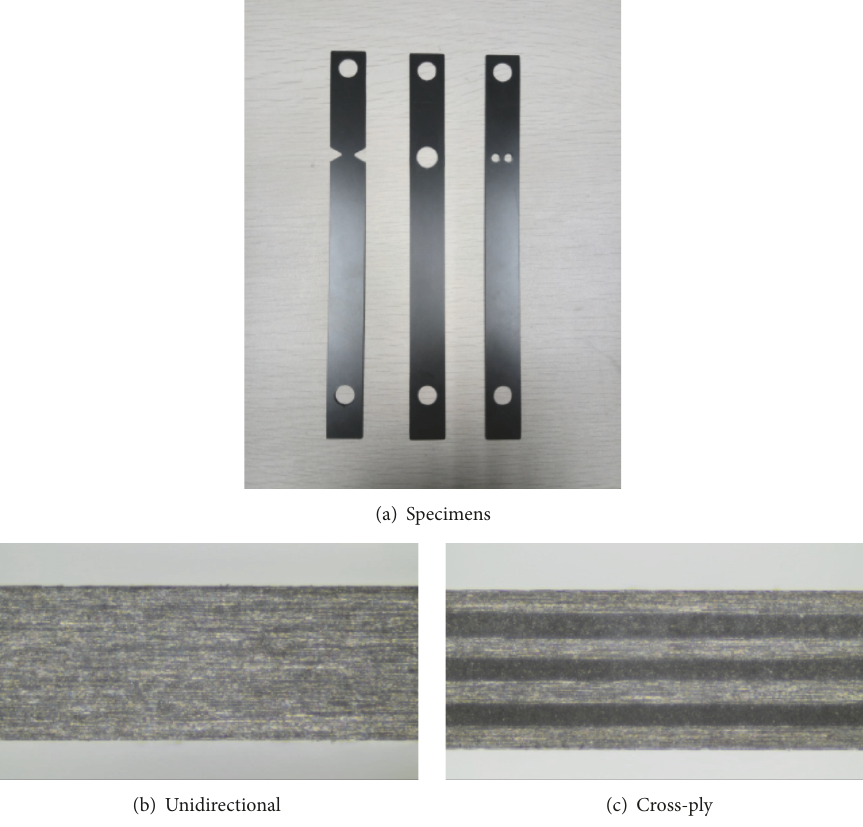
Figure 9: The top view and profile map of specimens.